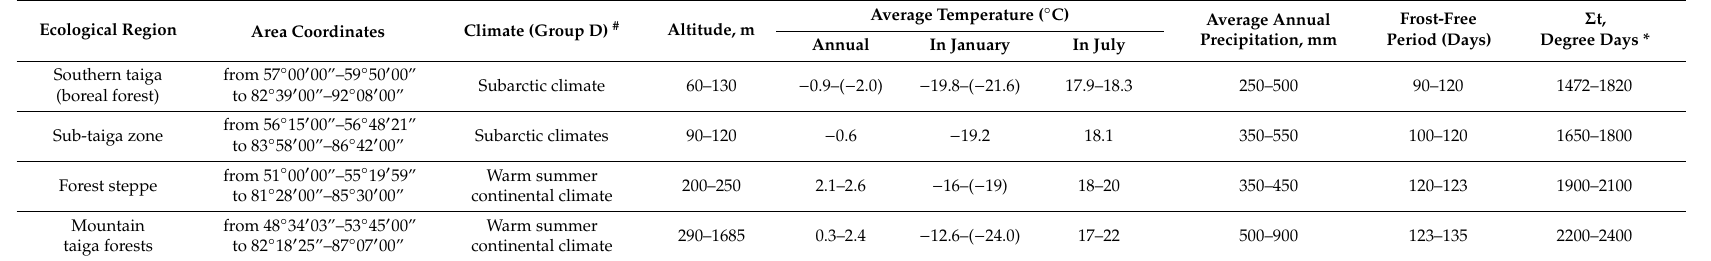
Table 1. Geographic and climatic characteristics of the study ecoregions of North